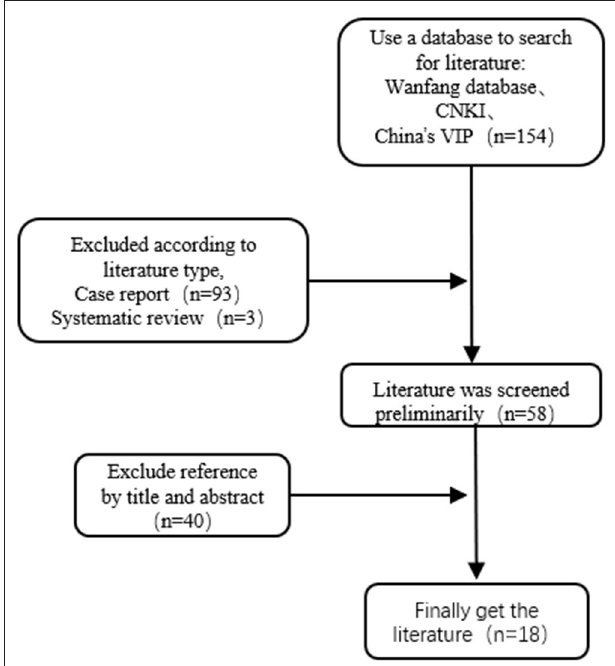
FIGURE 1 | Inclusion of literature